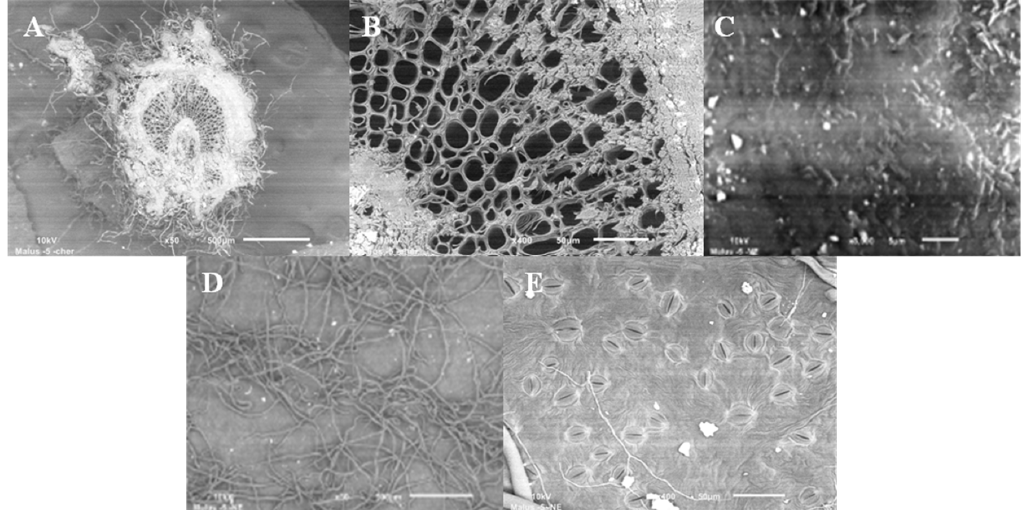
Figure 4. Malus baccata ‘Pendula’: A – transverse sections of the petiole; B – parenchyma cell